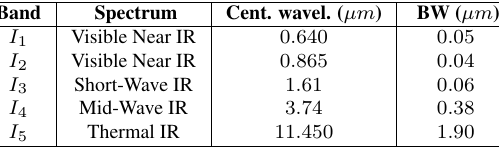
Non-Frozen Table 3: MODIS ground truth information on the cloud-free dates processed in 2011 - 12 . Band